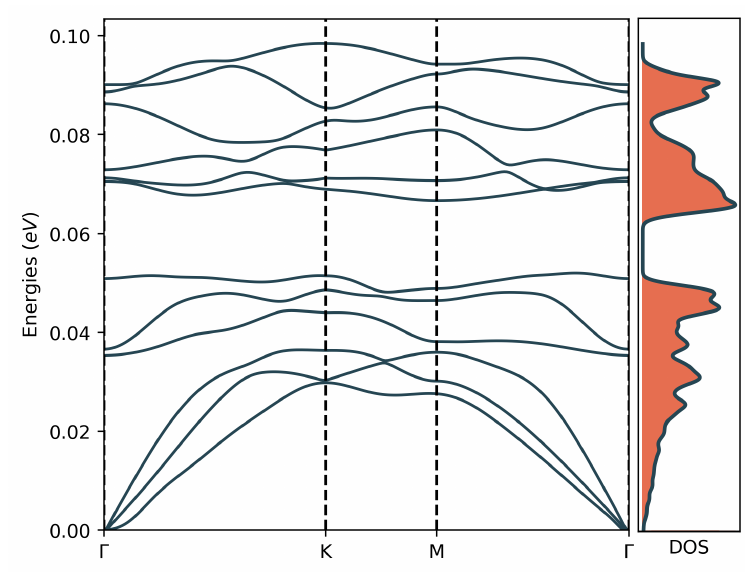
Figure 14: Phonons of monolayer LiCoO